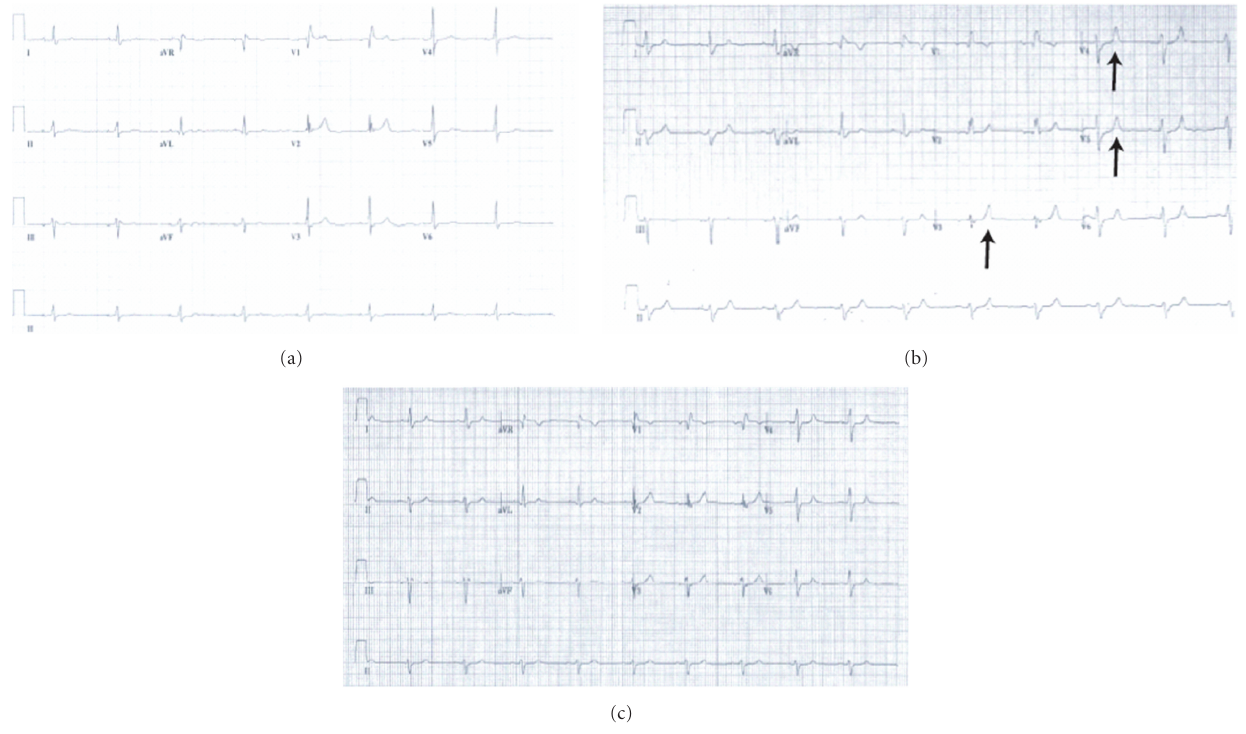
Figure 1: ECG changes during the hyperkalemic event, after treatment and a comparative old ECG. (a) Old ECG from March 2007; (b) peaked T-waves (arrows) in the setting of acute hyperkalemia; (c) improved EKG after